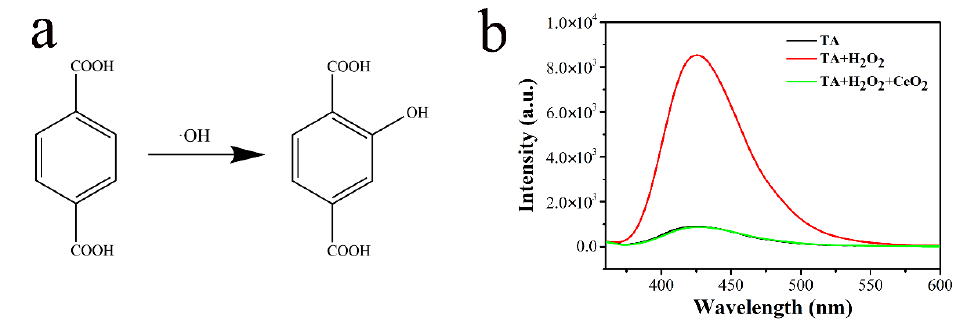
Figure 3. ( a ) Reaction between hydroxyl radical (OH) and terephthalic acid (TA); ( b ) fluorescence spectra of reaction system including only TA; TA and H 2 O 2 ; TA, CeO 2 , and H 2 O 2 after 2 h of reaction. [TA] = 0.5 mM, H 2 O 2 = 1 mM, [CeO 2 ] = 0.25 mg/mL.